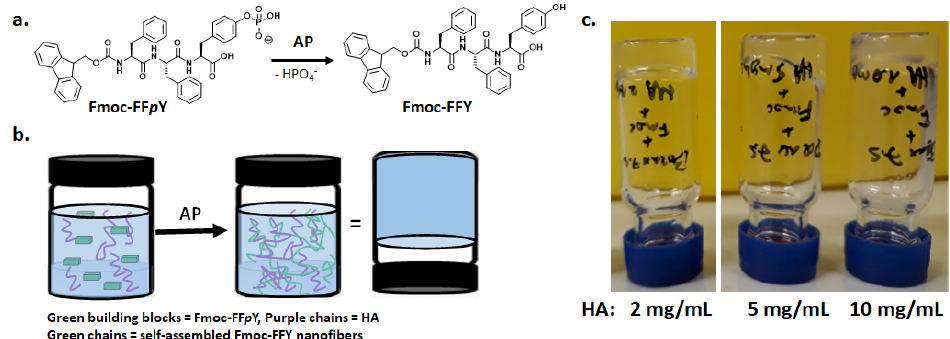
Figure 1. ( a ) Chemical structure of the precursor peptide Fmoc-FF p Y transformed in hydrogelator Fmoc-FFY in presence of an enzyme, i.e., AP; ( b ) Scheme of inverted tube test of a Fmoc-FFY hydrogel formed from Fmoc-FF p Y precursor and AP in presence of HA; ( c ) Inverted tube tests of self-assembled Fmoc-FFY hydrogels formed in Borax buffer solution (pH 9.5) in presence of various HA concentrations. HA